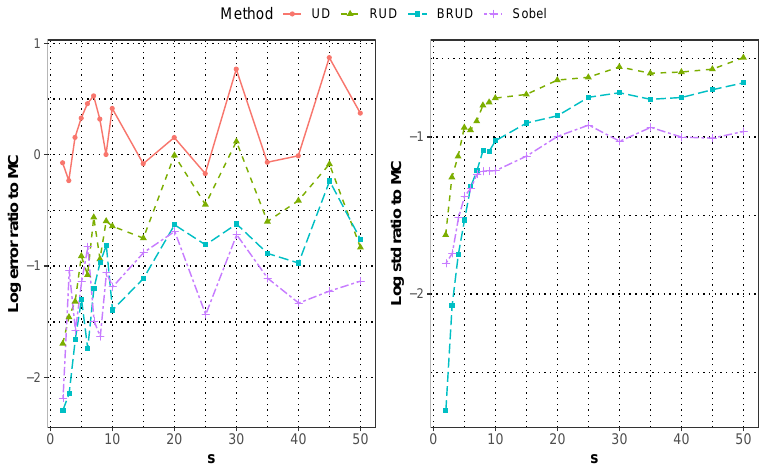
Figure 7. The median approximation error of integration of g ( x ) over all runs for different dimension.